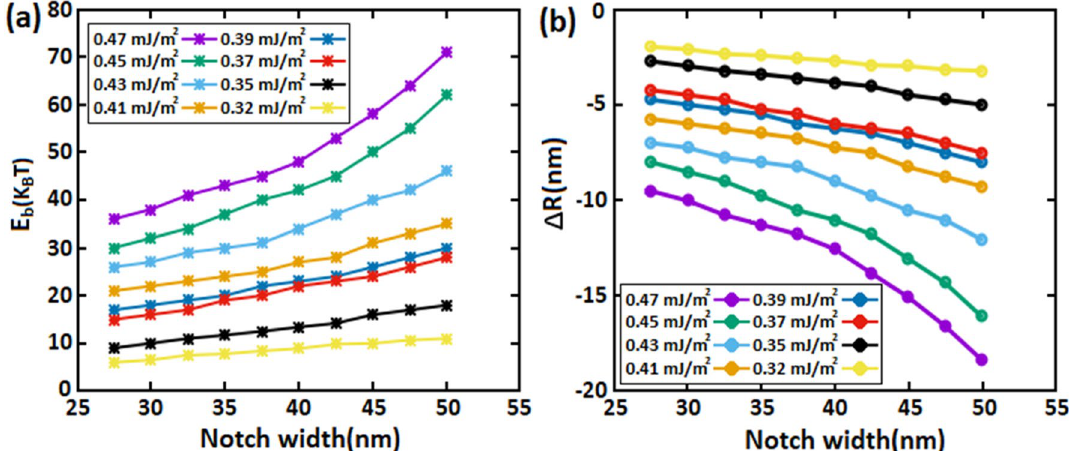
Figure 11. Energy barrier and skyrmion radius as a function of notch width (W n ) for various skyrmion